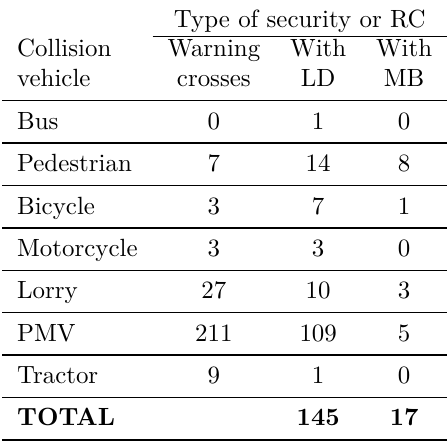
Table 3. Evaluation of accident statistics, collision vehicle vs. type of CR